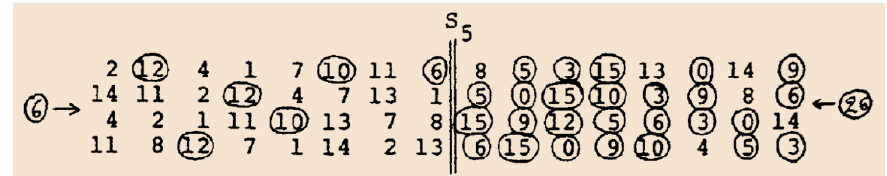
Figure 5: The 12 vs. 52 in S 5 — Scan from Adi Shamir’s CRYPTO’85 Paper